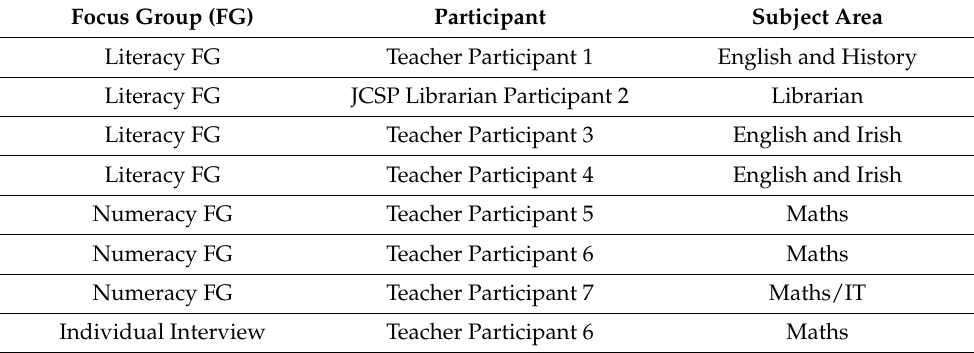
Table 1. Interview